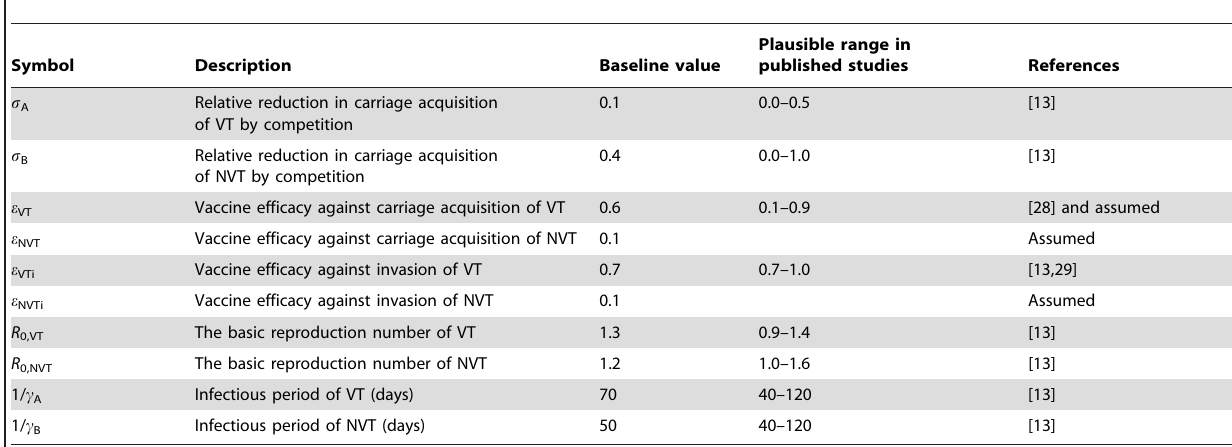
Table 2. Parameter values for the SIS (Susceptible-Infected-Susceptible) as applied to the epidemiological dynamics of Streptococcus